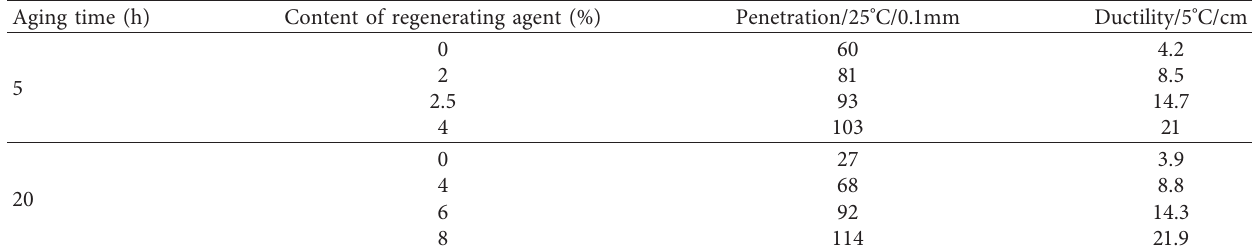
Table 3: Indexes of regenerating asphalt in different regenerating agent